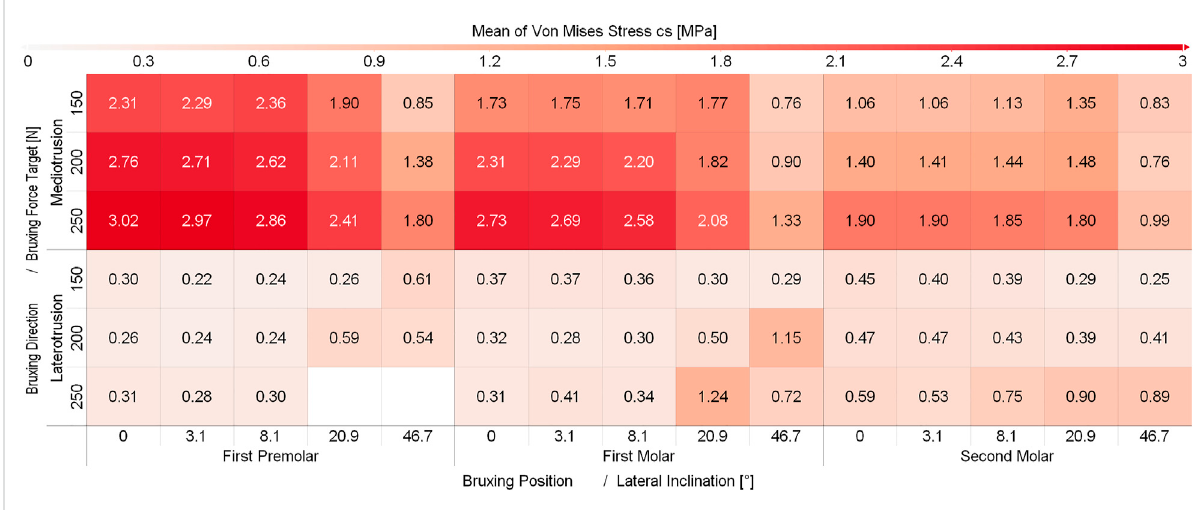
FIGURE 2 Mean von Mises Stress of the 200 highest loaded nodes on the contact side disc for different simulations.